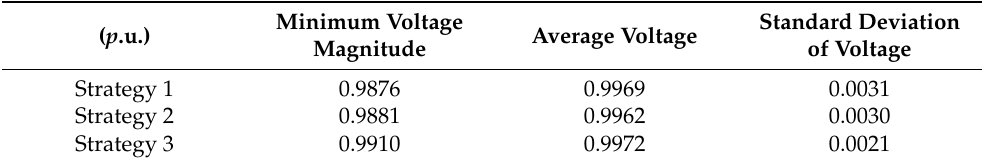
Table 5. Comparison of voltage quality of the three strategies. ( p .u.)